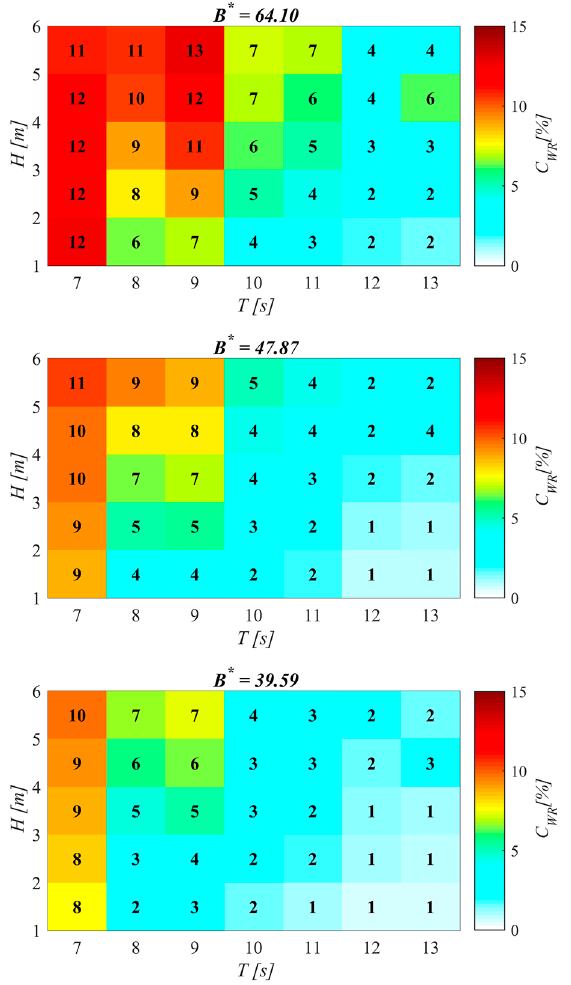
Figure 10. Variation of the capture width ratio ( C WR ) with the wave height ( H ) and wave period ( T ), or C WR matrix, for regular waves (Series A) and for different values of the damping coefficient ( B * ) (prototype data).